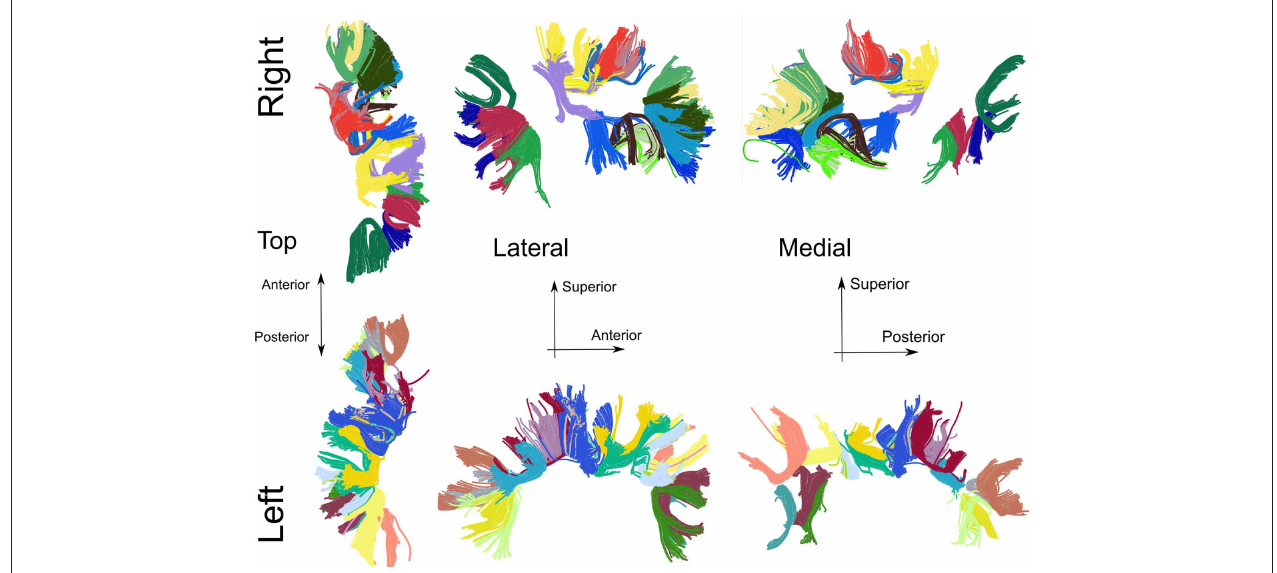
Figure 10 | Cortico-cortico u-shaped fibers generated with a Code Oracle script. The method to extract fibers from a subject uses criteria for fiber start and endpoint closeness, fiber curvature. The local skeleton clustering procedure (Garyfallidis et al., 2011) is used for the cluster coloring. The extracted U-fibers are cortical short distance connections hypothesized to contribute to the cortical small world network property (Bassett and Bullmore, 2006).